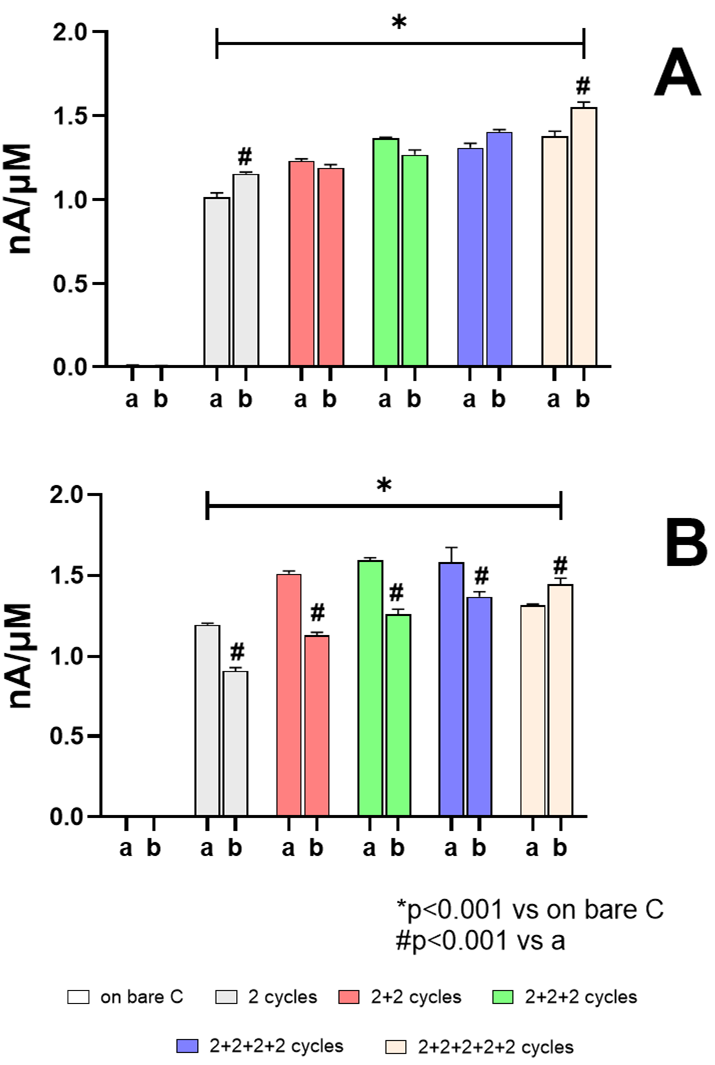
Figure 3. HP slopes, expressed as nA/ μ M ± SEM, resulting from CV protocols on CCRs after 2 consecutive cycles series, with HP and AA calibrations after each series, using 10 mM (panel ( A )) or 20 mM (panel ( B )) deoxygenated (a) and no deoxygenated (b) HA solution. n = 4; *: p < 0.001 vs. on respective bare C. #: p < 0.001 vs. a.